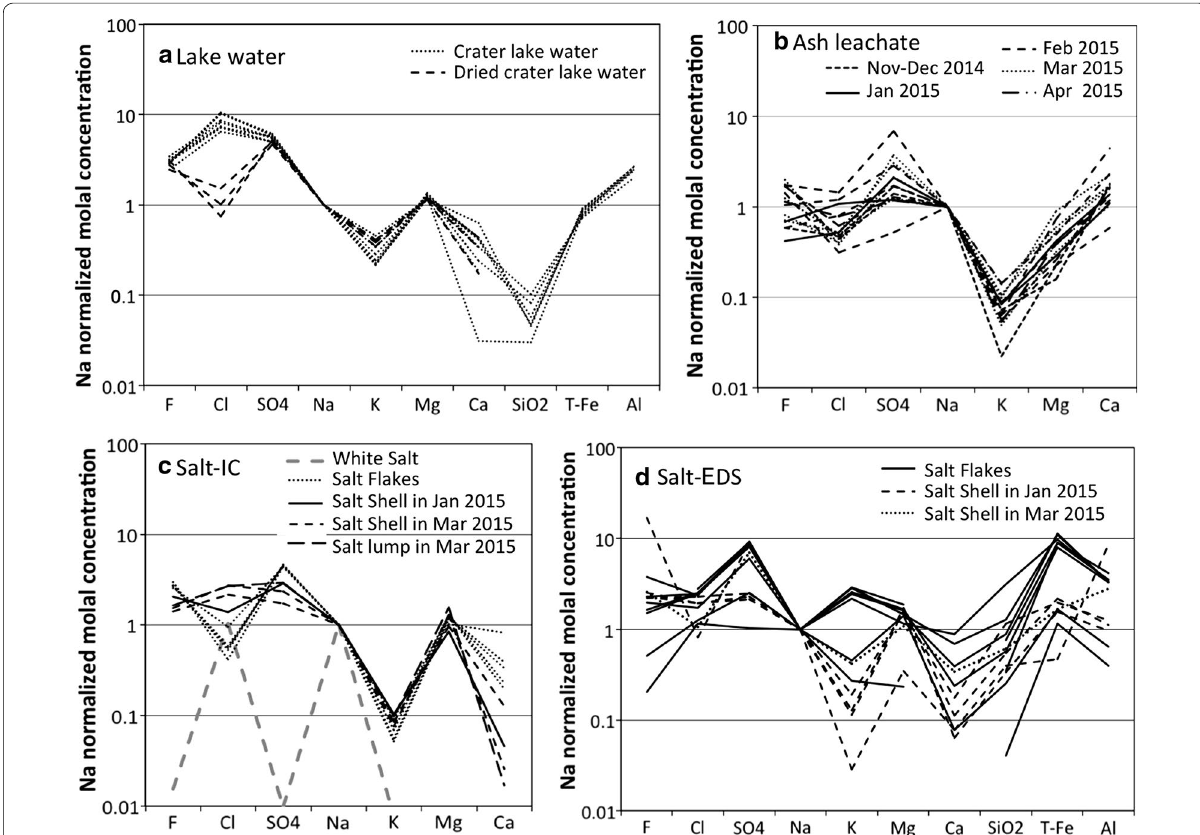
Fig. 2 Composition of the salt fallouts, ash leachates, crater lake waters, and dried samples of the crater lake waters (Table 1). The Na-normalized molal concentrations of each species are plotted. a Composition of the crater lake waters and of the dried samples of the crater lake waters. b Composition of the ash leachates. c Composition of the salt fallouts obtained by an ion chromatography analysis. d Composition of the salt fallouts obtained by an EDS